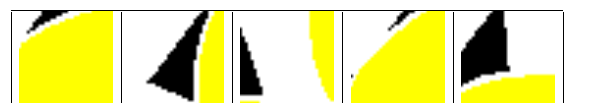
Figure 9. Example of training patches for the FCNpixel approach for classes beans and maize . The same color legend as in Figure 6: beans (black); maize (yellow); background